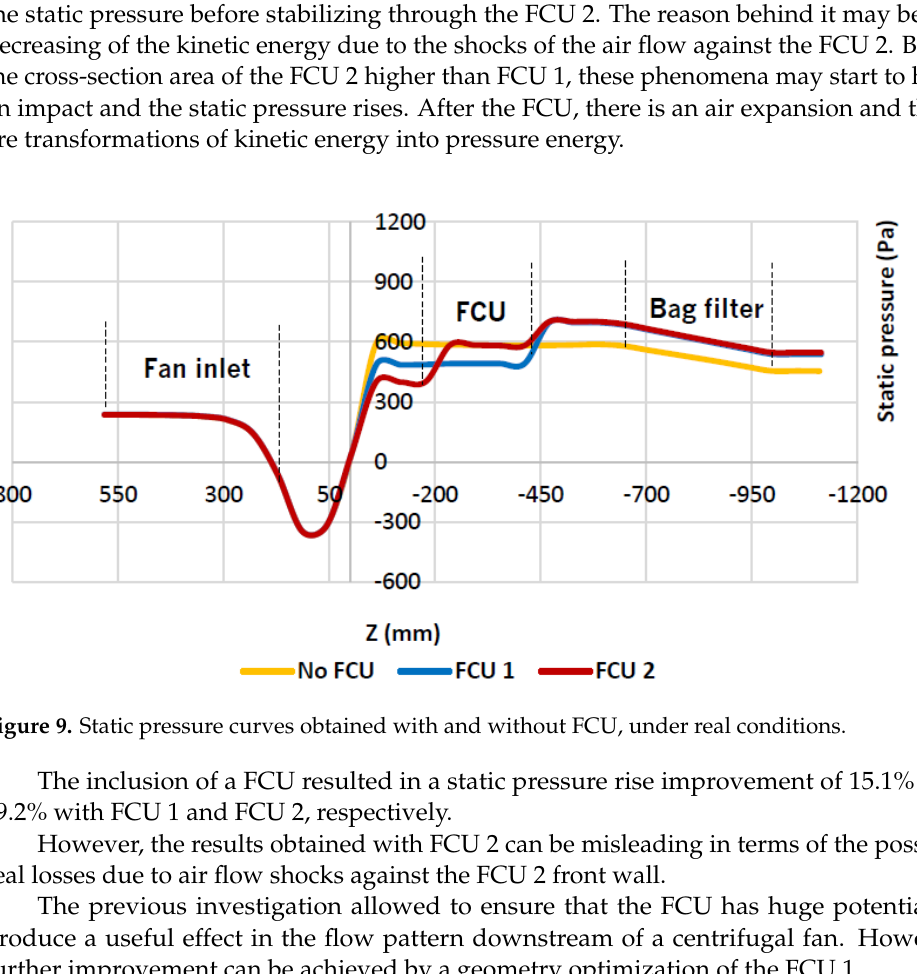
Figure 8. Velocity contour inside the AHU with ( a ) FCU1 and ( b ) FCU 2.